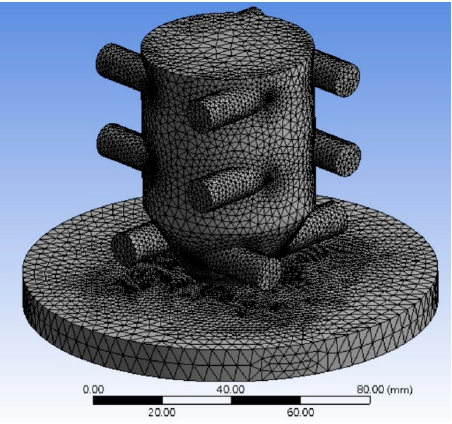
Figure 4. Three-dimensional geometry and mesh designed for numerical simulation. Table 1. Simulation